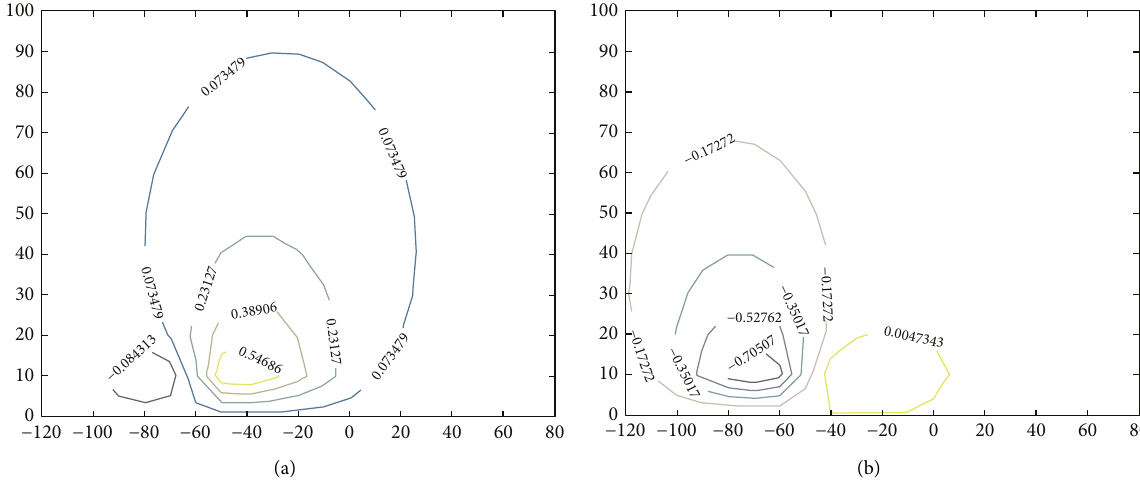
Figure 7: Contours of principal stress variation distribution of overlying strata. (a) Contours of maximum principal stress. (b) Contours of minimum principal stress. (The abscissa is the dip direction of the working face, the ordinate is the height, and − 60 m is the position of the working face).